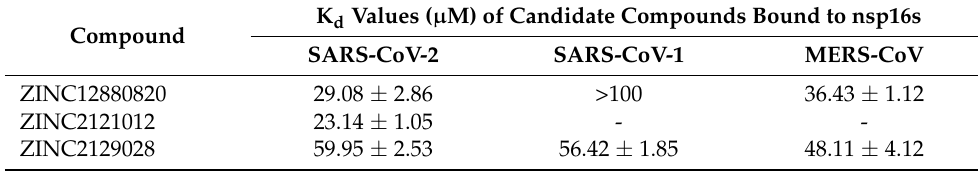
Table 2. K d values of the binding of the hits to nsp16 of SARS-CoV-2, SARS-CoV-1, and MERS-CoV measured by microscale